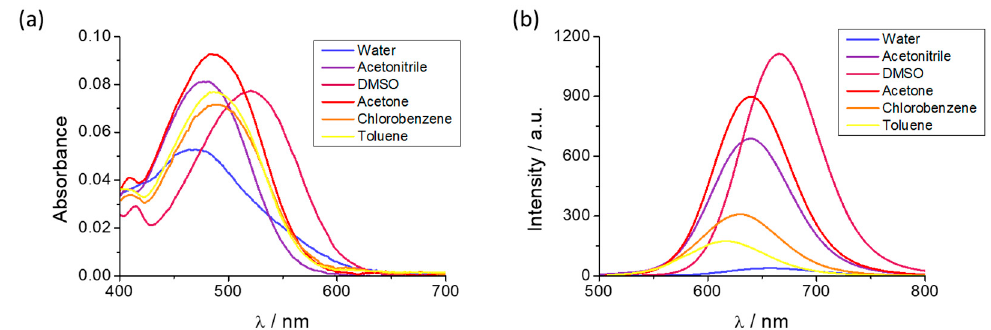
Figure 1. ( a ) Absorption spectra of the compound DCM-NH 2 , 1.7 μ M in different solvents. ( b ) Emission spectra of the compound DCM-NH 2 , 1.7 μ M in different solvents.